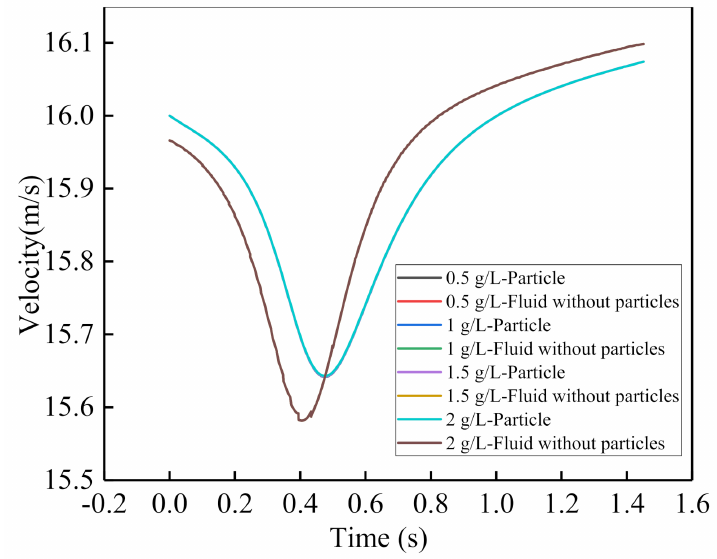
Figure 16. The particle velocities and the particle-free fluid velocities along the trajectory of particle ID = 5 under different particle